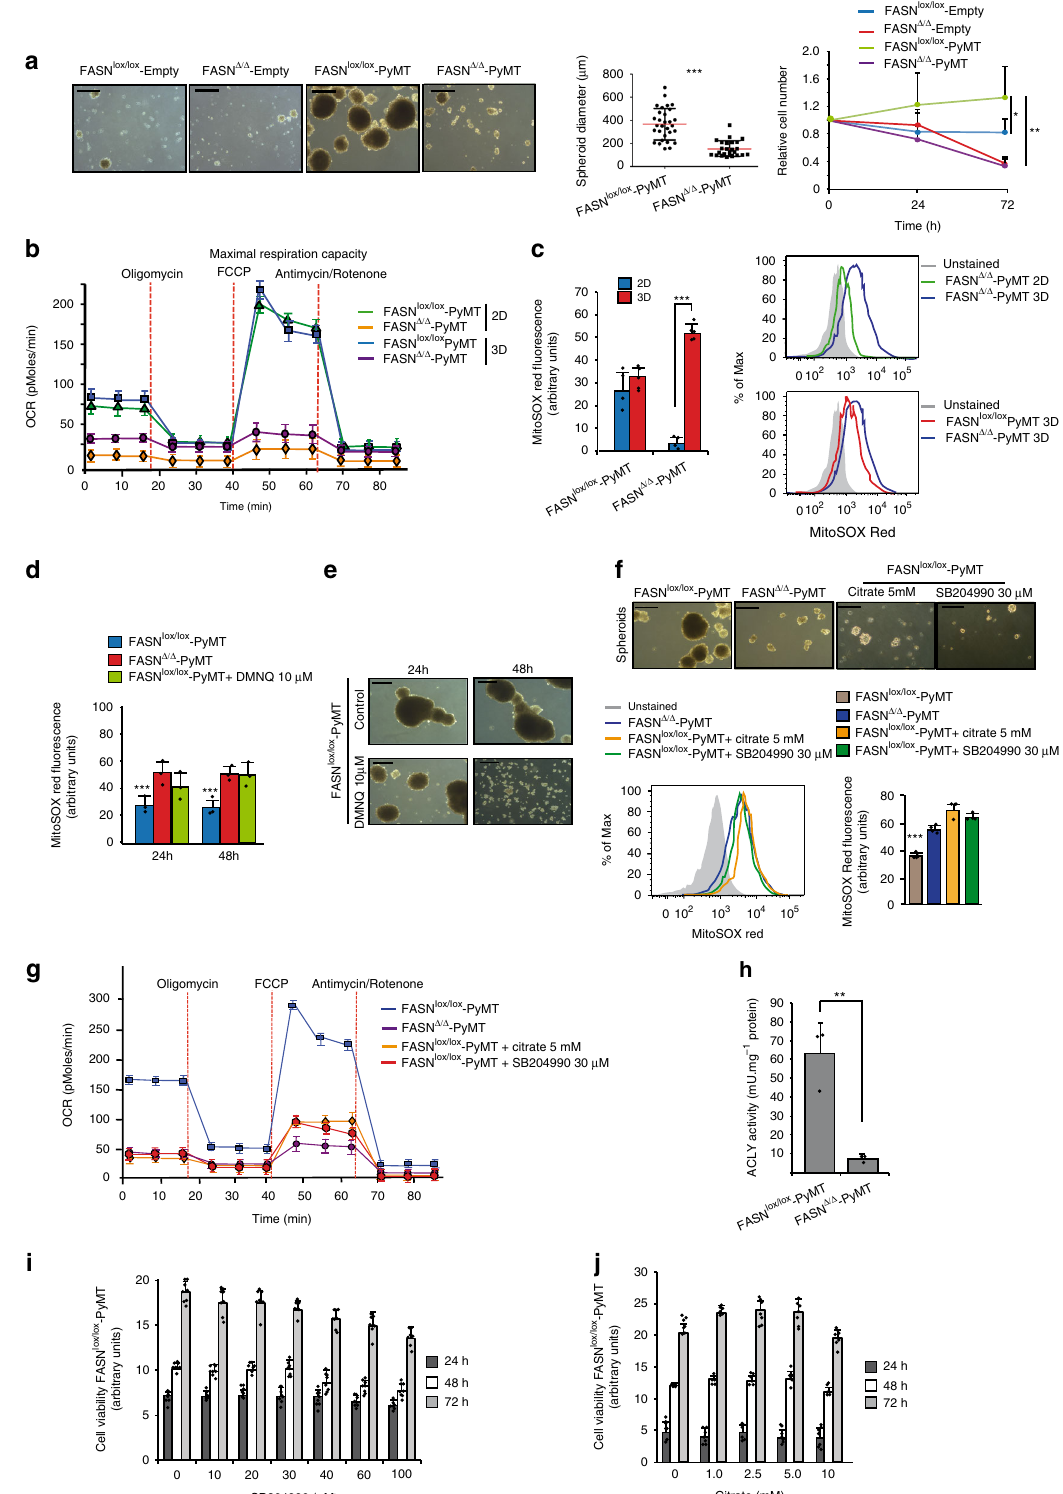
FASN-negative areas evidenced by the detection of FASN and 8- oxo-dG co-staining with monoclonal antibodies (Abs) 59 (Fig. 6d). The Kaplan – Meier curve shown in Fig. 6e depicts the differences in time to killing between FASN + / + ; PyMT and FASN Δ / Δ ; PyMT animals. Tumor volume is depicted in Fig. 6f. FASN Δ / Δ ;